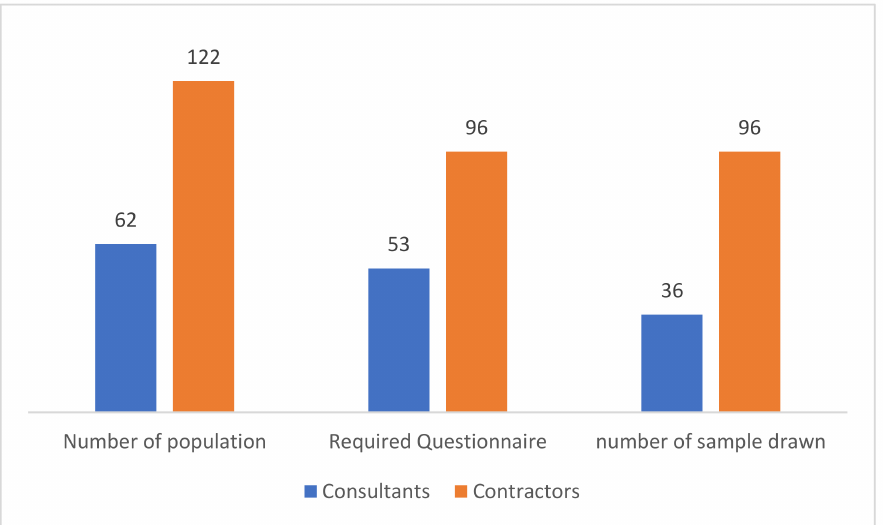
Figure 3. Population size and study